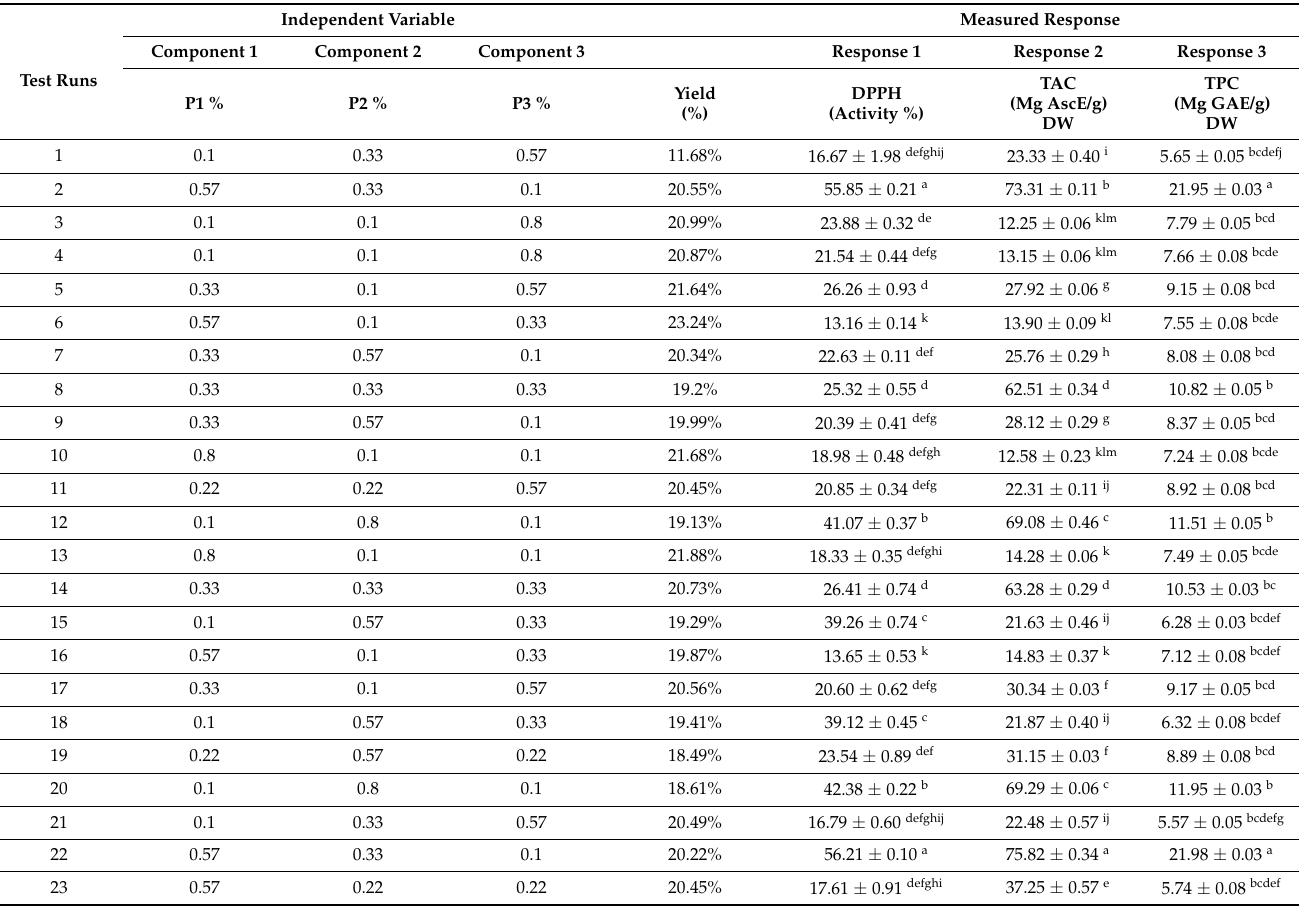
Table 1. Experimental design matrix and mean response